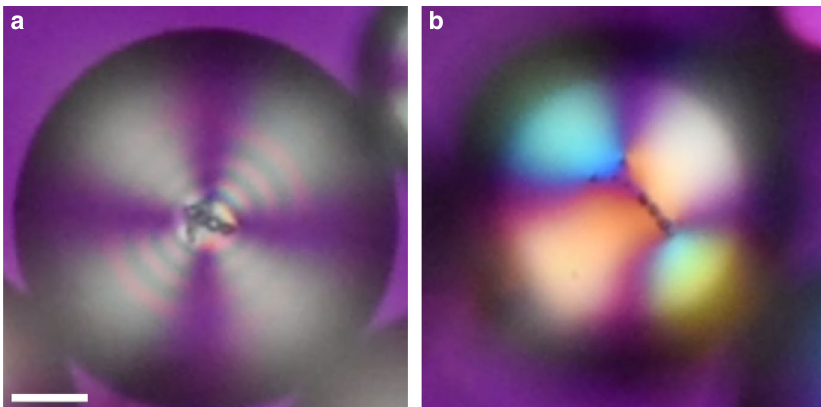
Fig. 4 Switching between primary satellite con fi gurations. Polarized microscopy images of a a nematic droplet with a tetrahedral structure in the center and b the same nematic droplet after external agitation on the brink of the nematic to isotropic phase transition. Full waveplate is inserted at 45° to the crossed polarizers to con fi rm radial orientation of the director fi eld. Scale bar: 10